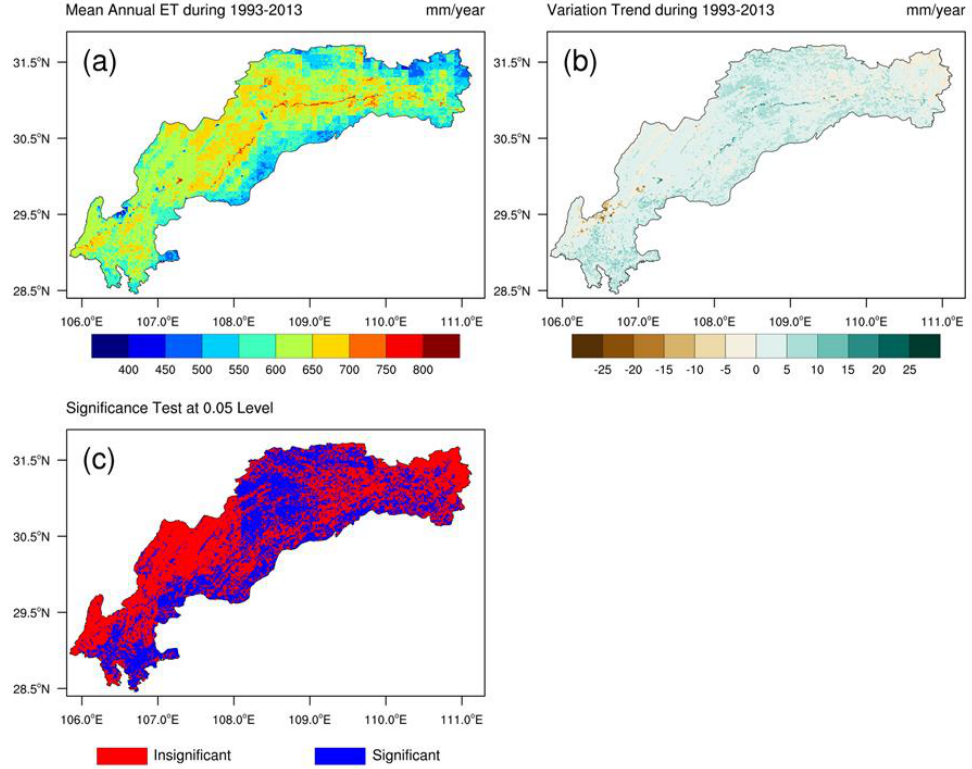
Figure 9. The spatial distribution and variation trend of annual ET.